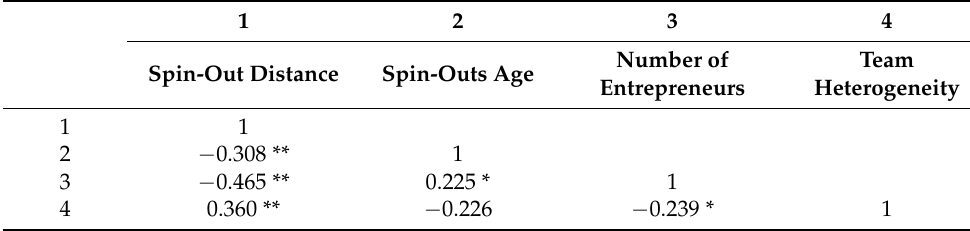
Table 7. Multiple-founder spin-outs correlation (m.: